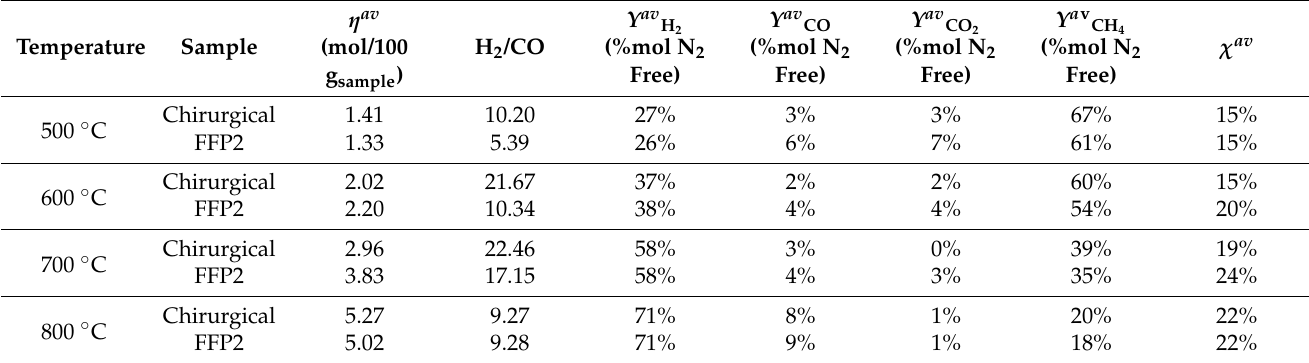
Table A1. Average values of pyrolysis parameters in N 2 atmosphere for dry samples.